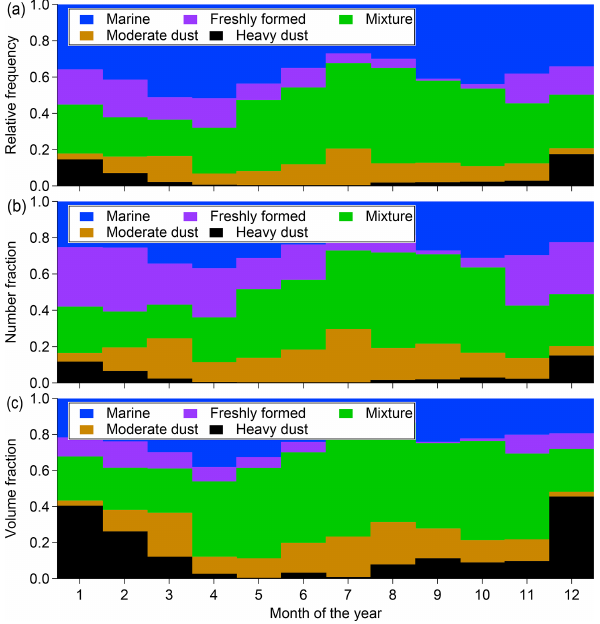
Figure 10. Monthly variation of relative frequency (a) , number fraction (b) and volume fraction (c) of different aerosol clusters.